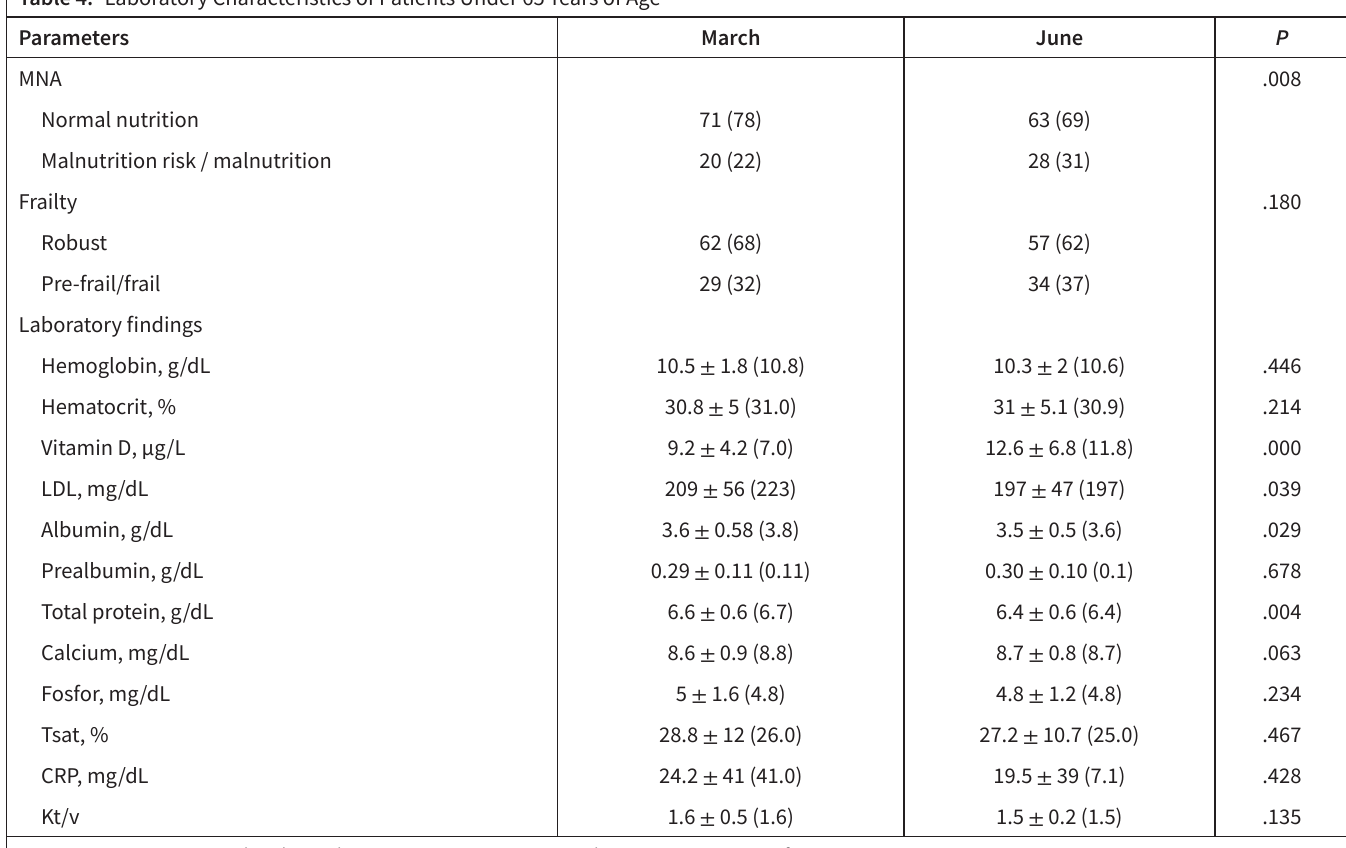
Table 4. Laboratory Characteristics of Patients Under 65 Years of Age